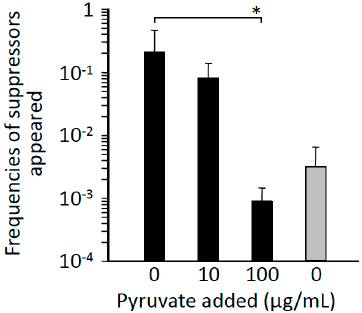
Figure 6. Effects of culture conditions on appearance of L-alanine prototrophic suppressors in minimal medium. HYE032 cells were inoculated into the minimal liquid medium and grown aerobically (black bars) in the presence of pyruvate (10 and 100 μ g/mL) or grown anaerobically to the late-log phase (grey bar). Subsequently, the frequency of appearance of suppressors was measured. Data represent means and standard deviation from 3 independent experiments. Statistical analyses; * p < 0.05.